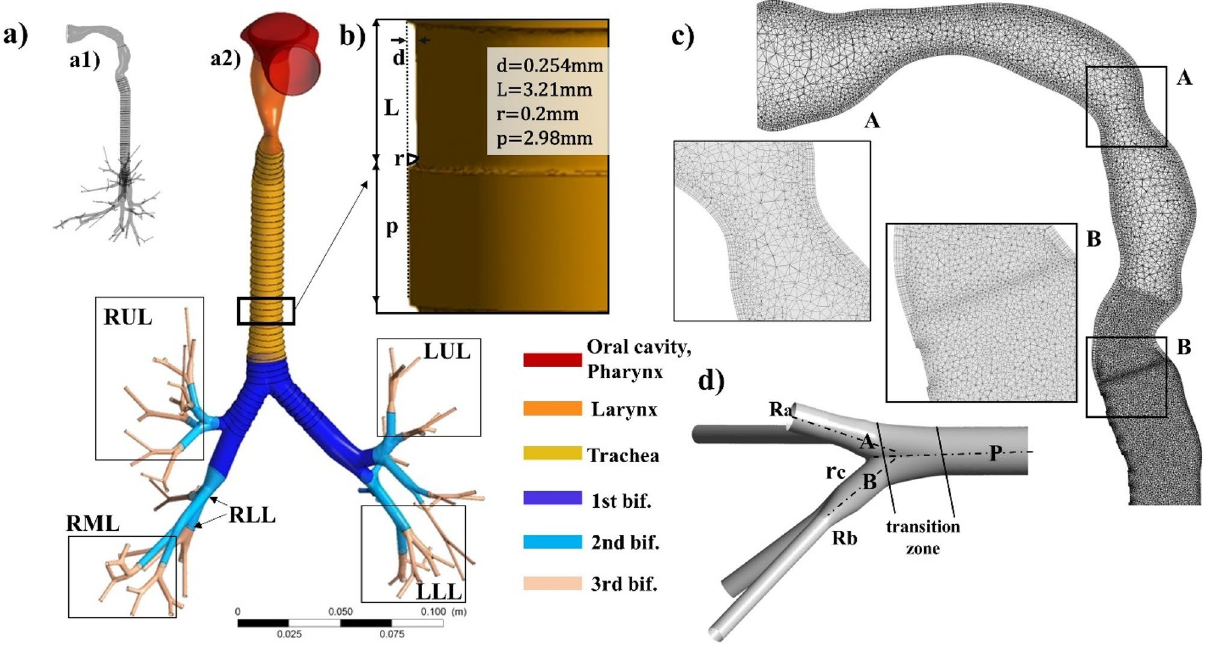
Figure 8. 3D realistic airway tree model in details: ( a ) lateral and frontal view of the 3D realistic airway tree created and the correspondent lobes: right-upper (RUL), right-medium (RML), right-lower (RLL), left-upper (LUL) and left-lower (LLL). ( b ) Dimensions of the cartilaginous rings, based on in-vitro observations of Russo et al. 39 ; p and L are the step and the width, respectively, d is the depth of the ring and r is the fillet radius. ( c ) Representative computational grid of the